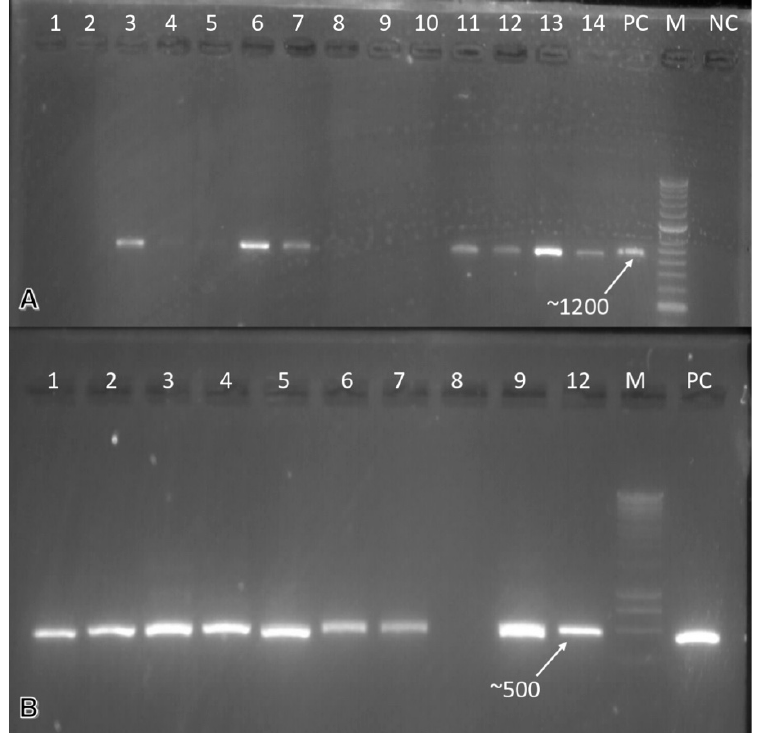
Figure 3. Gel electrophoresis profile of cucurbit viruses: ( A ) Molecular detection of the ToLCNDV in two cucurbit crops samples (zucchini and watermelon) using specific primers. Lanes 1–7 are watermelon samples, lanes 8–14 are zucchini samples, lane M is M-1Kb DNA stepladder (Thermo Fisher scientific, Vilnius, Lithuania), lane NC is a negative control, and lane PC is a positive control. ( B ) Molecular detection of the CpCDV in watermelon and chickpea samples using specific